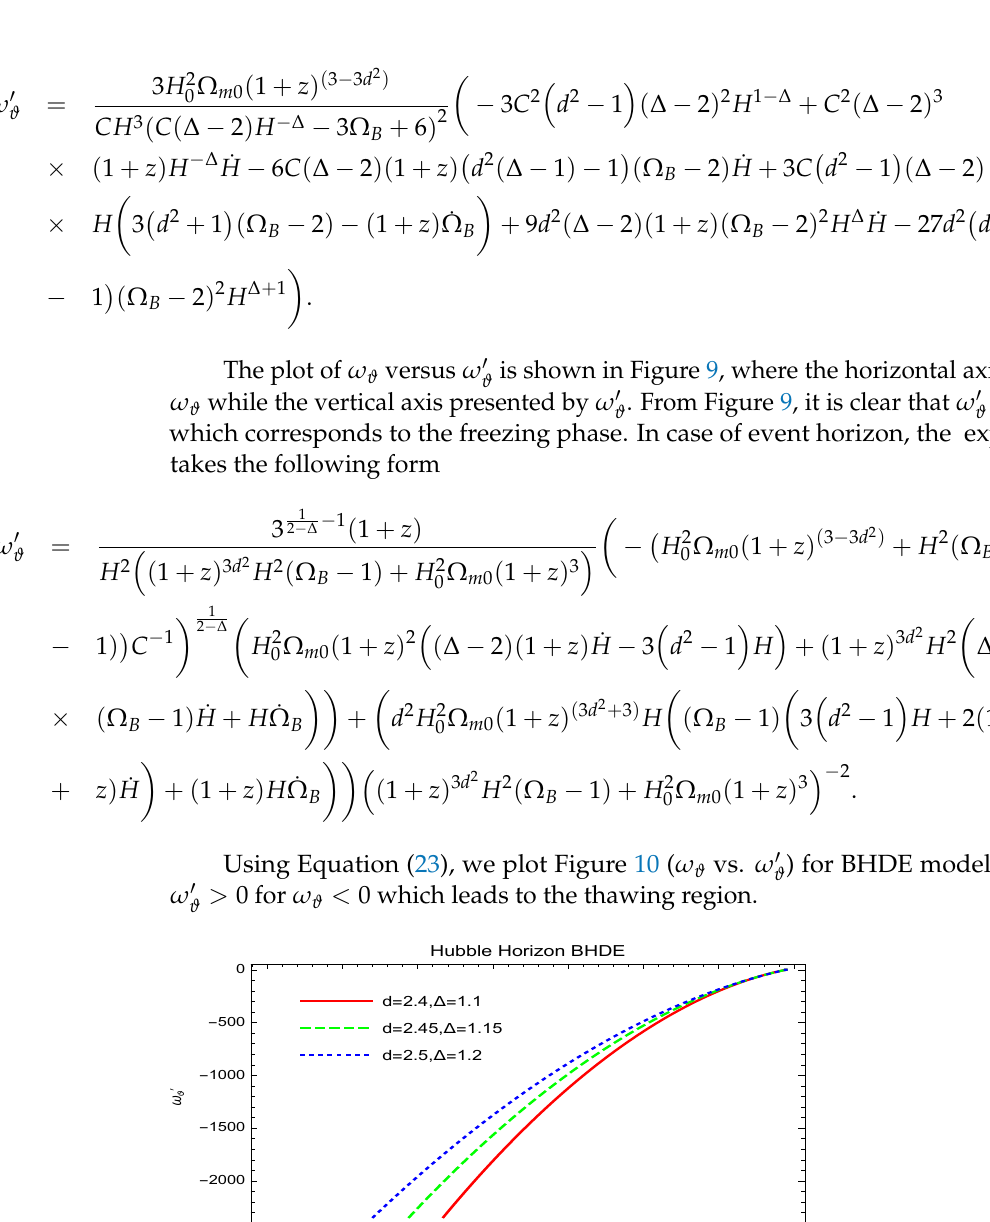
for interaction BHDE model with Hubble horizon in the ϑ